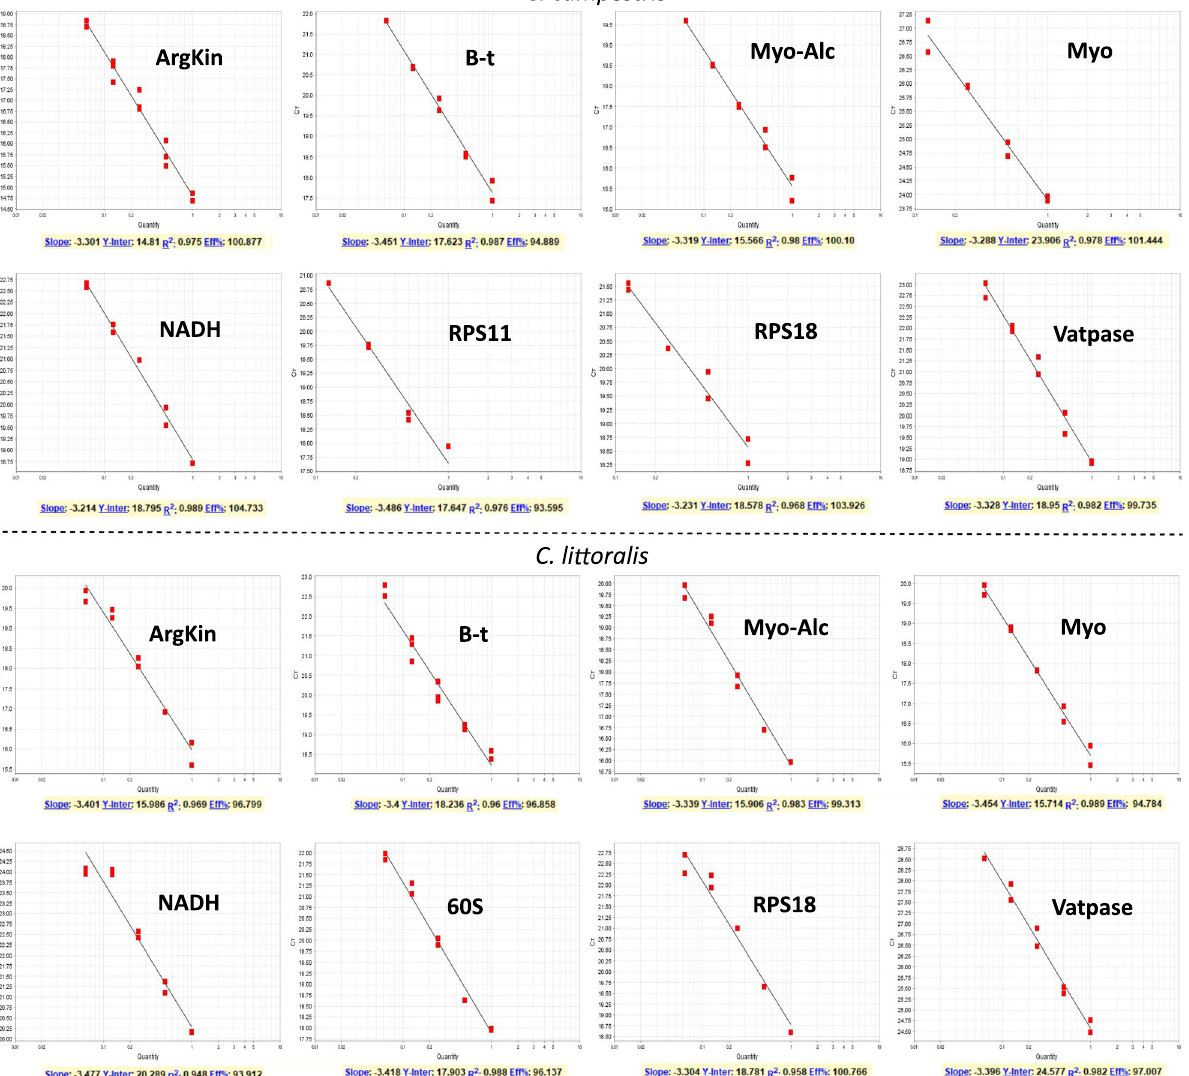
Figure 2. Standard Curves of all genes tested for both of the species studied showing efficiencies and the slope and R 2 values